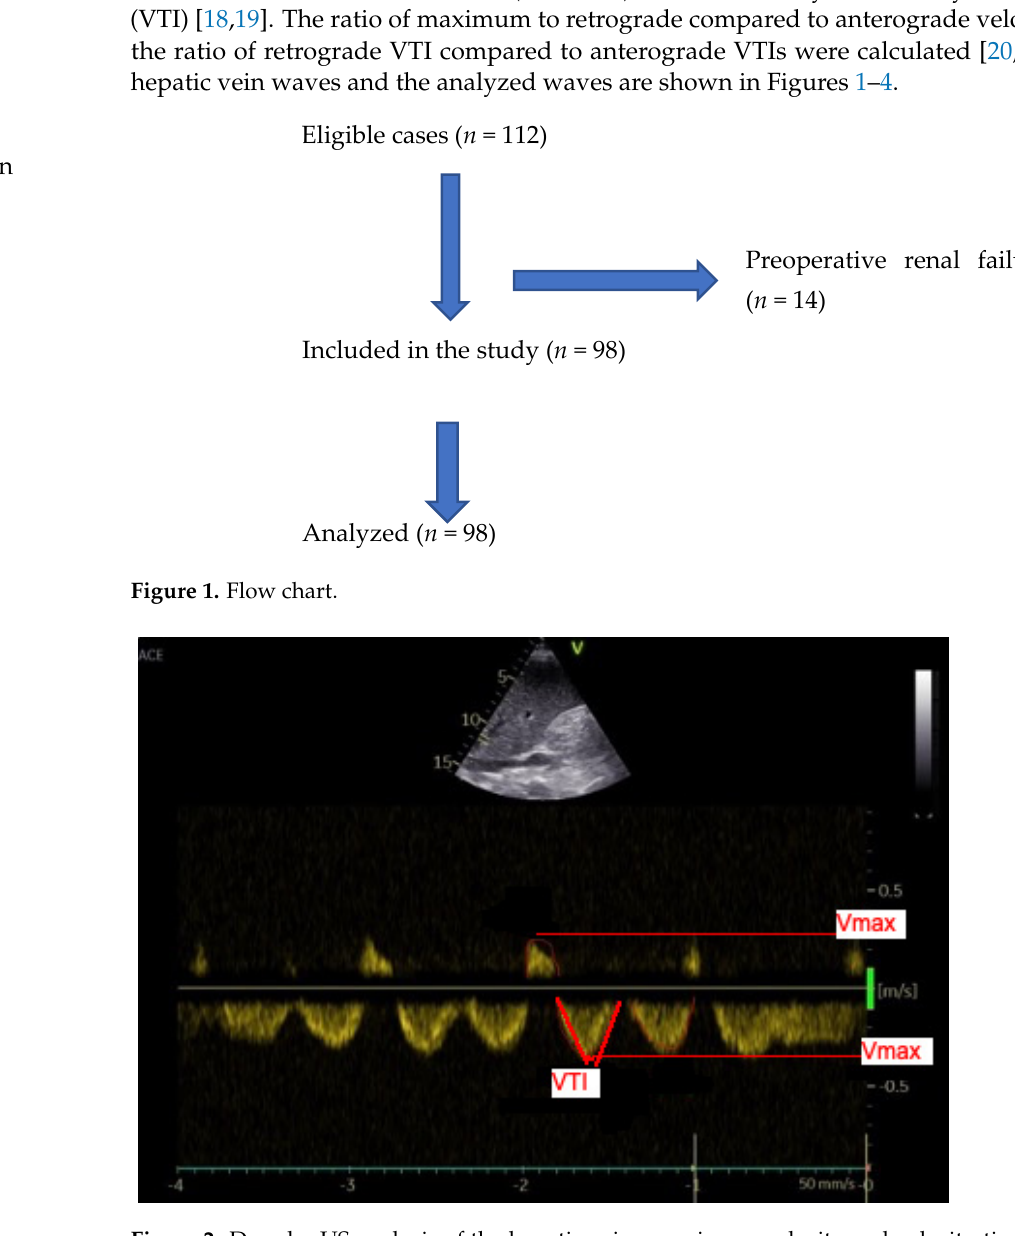
Figure 3. Doppler ultrasound analysis of the hepatic veins–maximum velocity and velocity-time integral were measured (a line was adjusted to the maximum point and continuous wave Doppler’s spectral curve was calculated by the machine. A and V waves are retrograde, S and D are antero- grade waves).